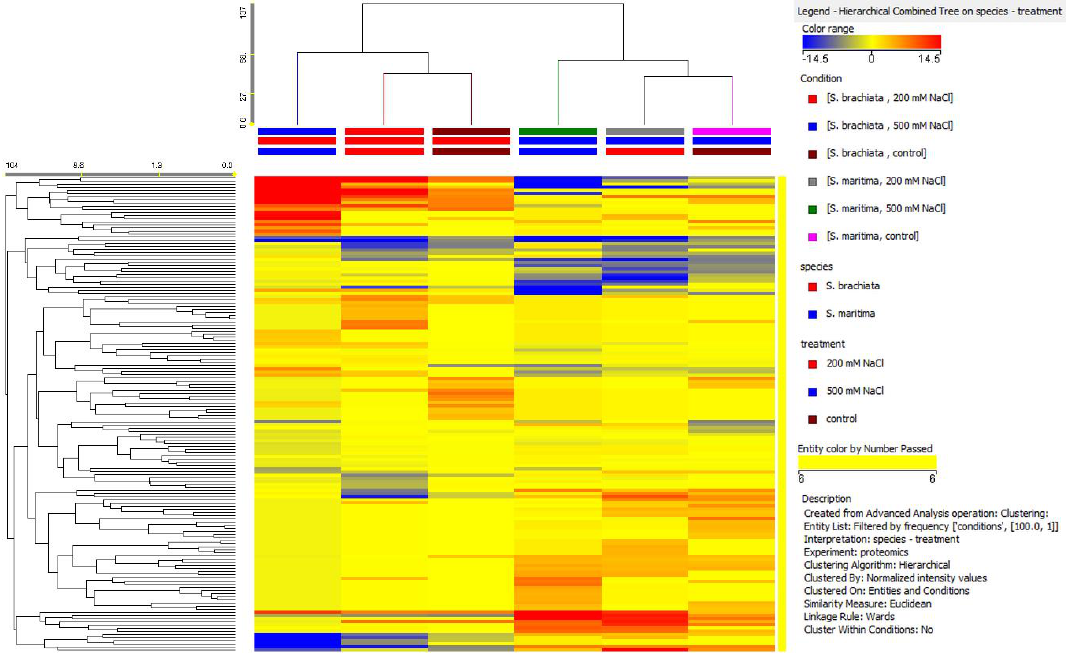
Figure 1. Unsupervised hierarchical cluster analysis of Salicornia brachiata and Suaeda maritima treated with 200 mM NaCl and 500 mM NaCl. Clustering was carried out on both conditions (treatments, vertical dendrogram) and compounds (proteins, horizontal dendrogram).